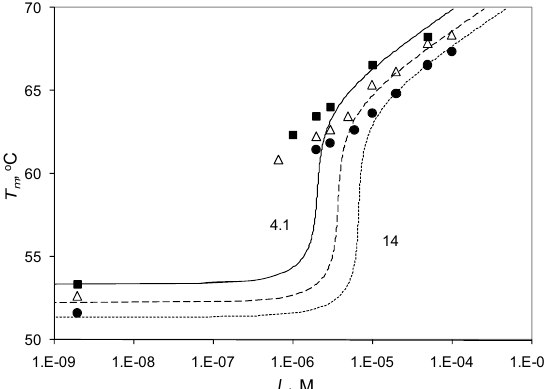
Figure 4. The dependence of the melting temperature of Hsp90 α N on radicicol concentration. The data points show the melting temperatures of ligand-bound components at three protein concentrations: (cid:132) - 4.1 µM, Δ - 7.5 µM, and (cid:122) - 14 µM. The T ligand-free Hsp90 α N component is omitted for clarity. The leftmost data points are controls with no radicicol added. Lines are drawn according to Equation (12) and represent the best possible fit of the data. The solid line is for 4.1 µM, the dashed line for 7.5 µM, and the dotted line for 14 µM protein.